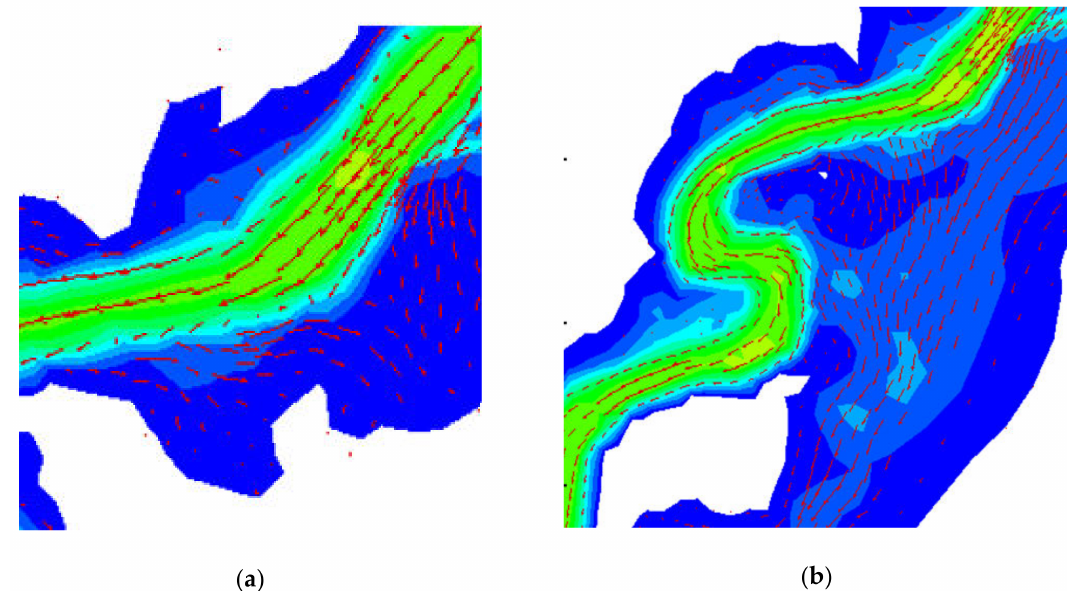
Figure 8. Flow field distribution: flow field near the breach ( a ), water-blocking and water-diversion e ff ect of dike and local topography ( b